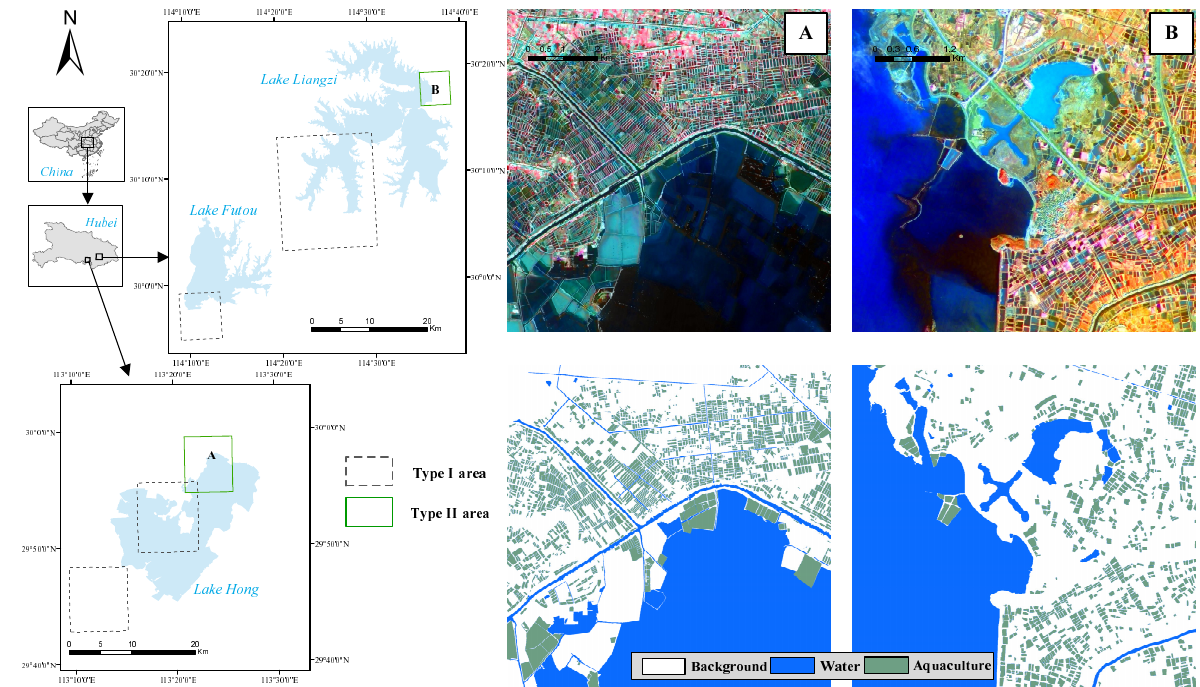
Figure 1. Location of the study area. The pseudo-colour images ( A , B ) are pansharpening images using the near infrared, the red and the green band as red, green and blue. The corresponding labelling image for each is given